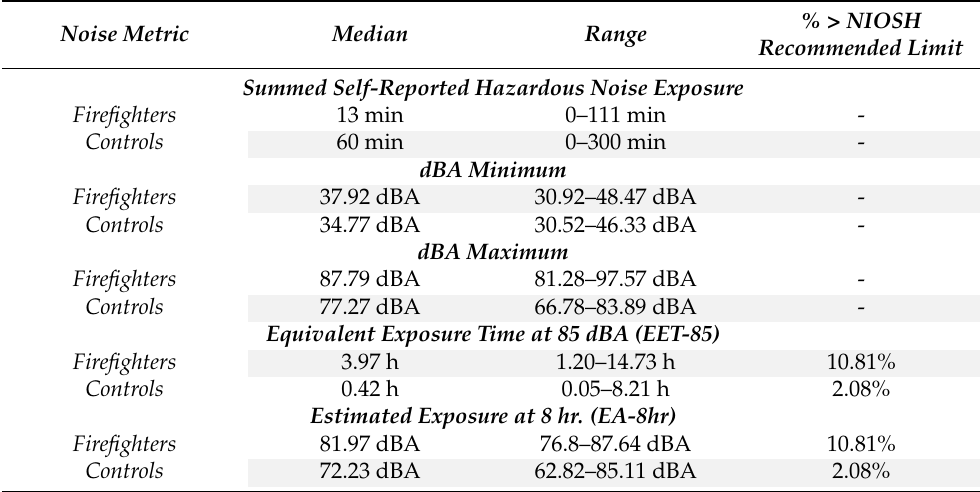
Table 5. Noise metrics for firefighters and controls.